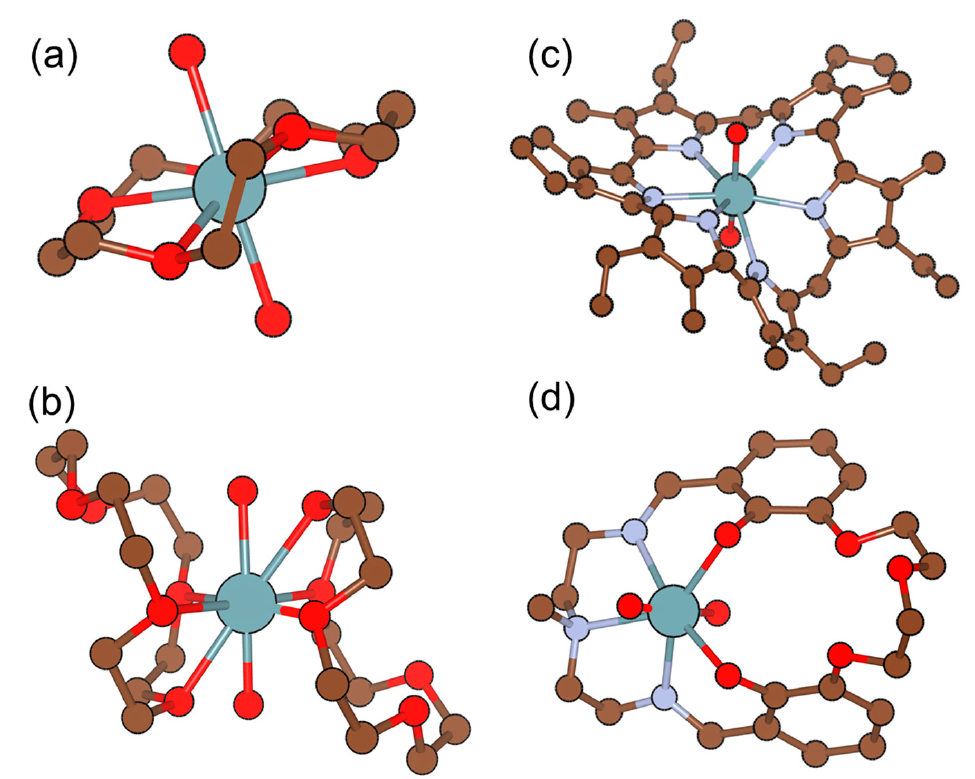
Figure 6. Illustration of the structure of ( a ) the inserted uranyl 15-crown-5, ( b ) sandwich uranyl di- 15-crown-5 complex, ( c ) uranyl-hexaphyrin complex and ( d ) uranyl 3,3 ′ -(3-oxapentane-1,5-diyldi- di-15-crown-5 complex, ( c ) uranyl-hexaphyrin complex and ( d ) uranyl 3,3 (cid:48) -(3-oxapentane-1,5- oxy)bis(2-hydroxybenzaldehyde) complex. diyldioxy)bis(2-hydroxybenzaldehyde)